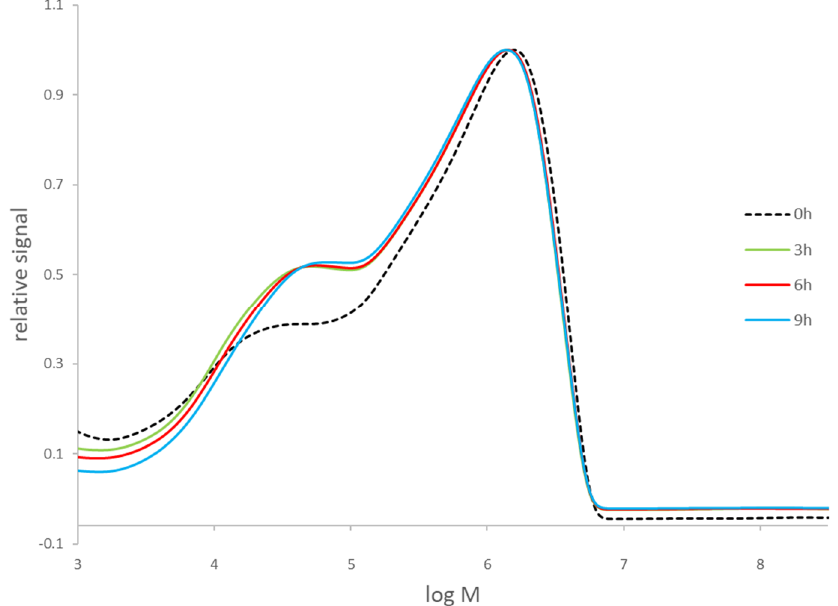
Figure 1. Molecular mass distribution of CTC derivatives for sample No. 1, untreated (0 h) and after delignification for 3, 6, or 9 h.